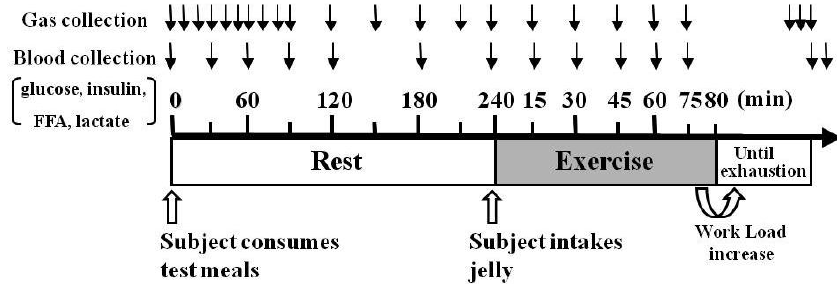
3 min before exercise. Abbreviations: FFA, free fatty